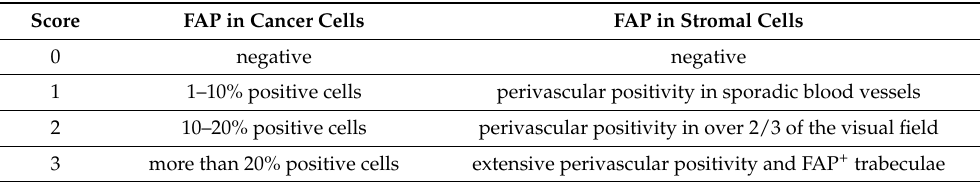
Table 2. Semiquantitative FAP immunopositivity scoring in glioblastoma sections (see Figure 1 for representative